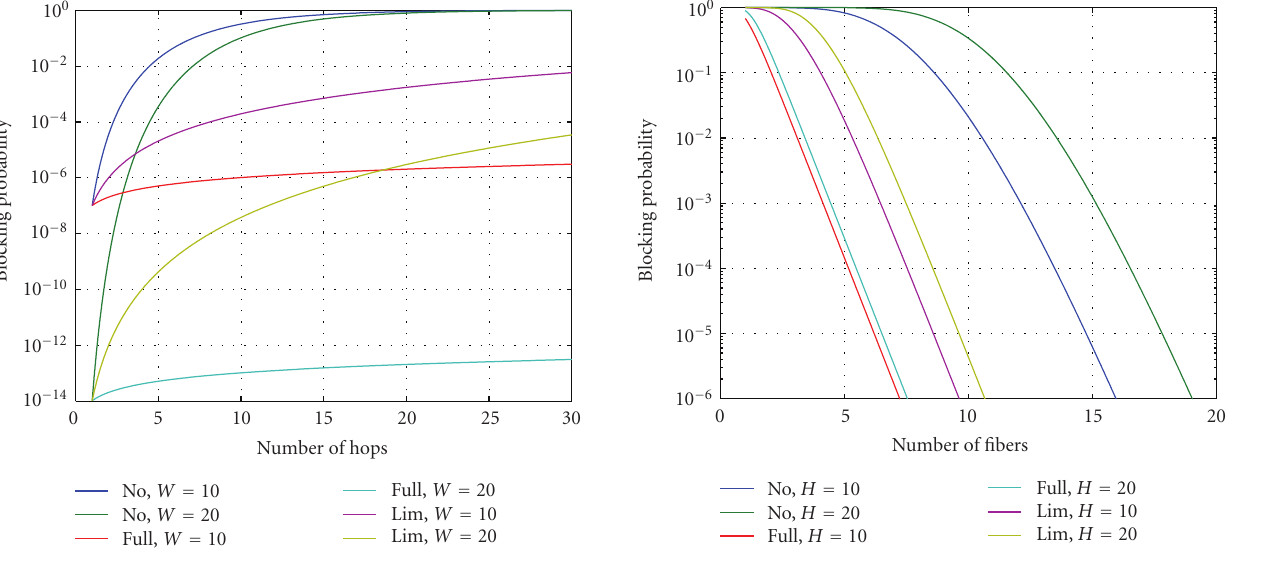
Figure 6: The blocking probability P b = f ( F ), ρ = 0 . 8, W = 10, and k =